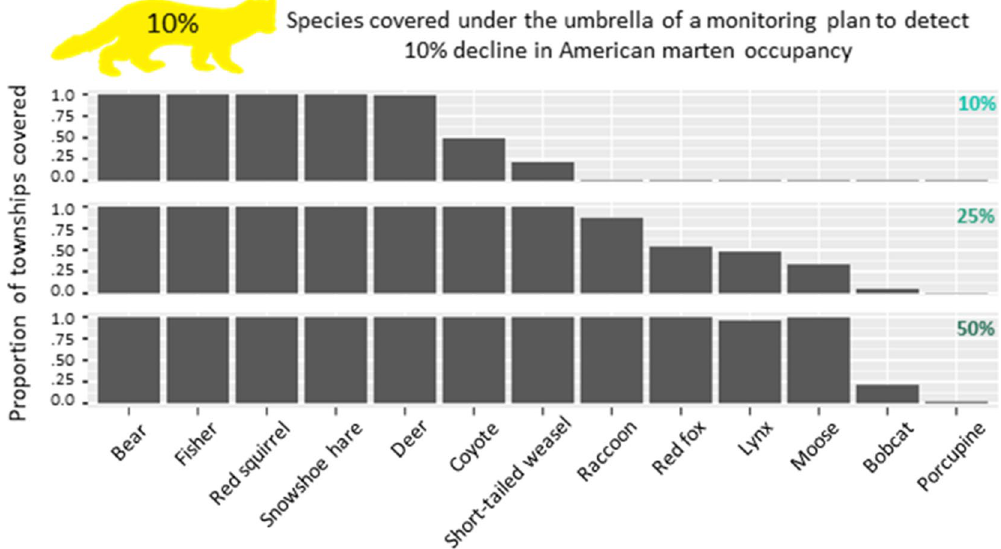
Figure 3. Umbrella effect (10% marten decline). The figure shows the proportion of townships per species that are covered under the 10% marten decline sampling protocol. The top figure shows a 10% decline for each species i.e. a 10% marten decline sampling effort would cover 100% of townships for the bear under a 10% change in bear occupancy scenario. The middle figure shows a 25% decline for each species i.e. a 10% marten decline sampling effort would cover approximately 50% of townships for the red fox under a 25% change in red fox occupancy scenario. The bottom figure shows a 50% decline for each species i.e. a 10% marten decline sampling effort would cover approximately 25% of townships for the bobcat under a 50% change in bobcat occupancy scenario.